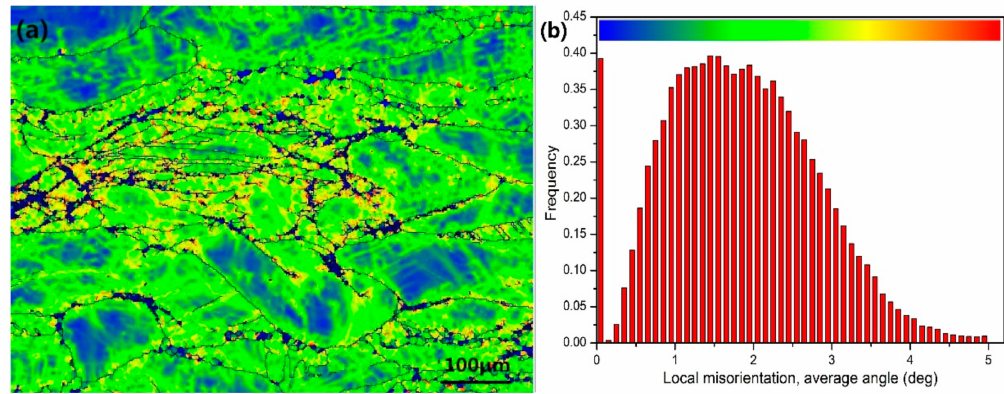
Figure 6. The local misorientation map ( a ) and ( b ) the frequency of the local misorientation (350 ◦ C, 0.01 s − 1